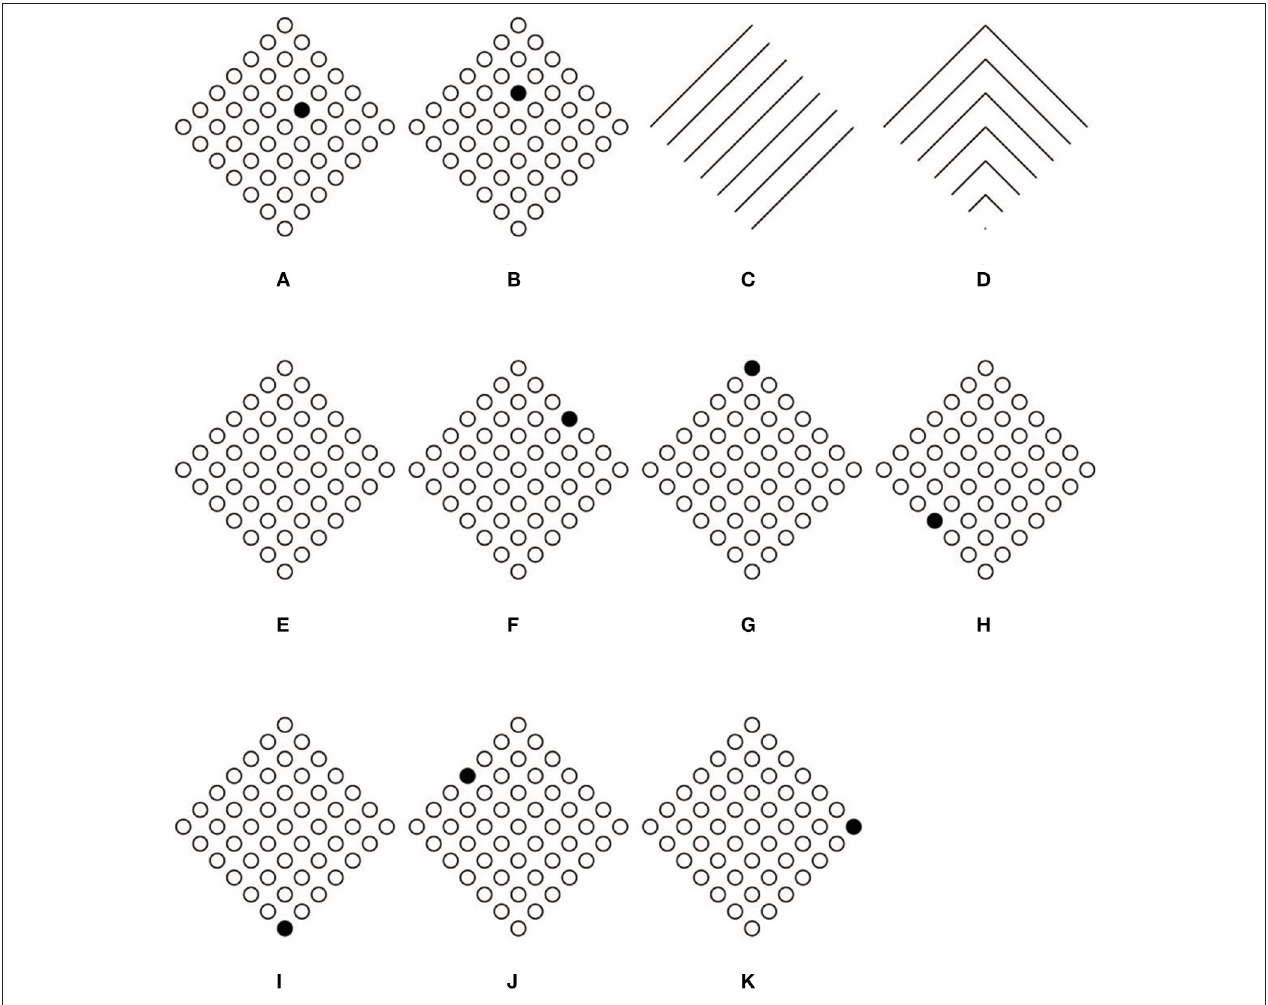
FIGURE 5 | The dissimilar element defines and punctuates the directions of the grouping of the empty circles. Conditions (C,D) illustrate the directions of the grouping of figures (A,B) . Condition (E) is a control. The dissimilar element acts like a vector and its location makes figure change their direction (F–K) .